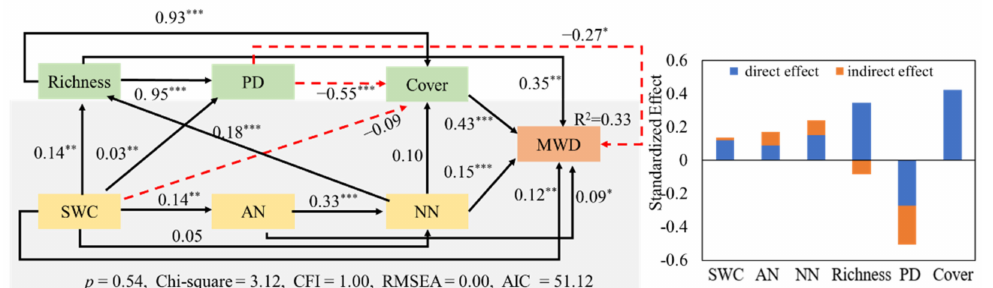
Figure 6. Effects of plant characteristics and soil factors on soil aggregate stability in the desert margin. Note: SWC, AN, NN, Richness, PD, and cover represent soil water content, soil ammonium nitrogen, soil nitrate nitrogen, species richness, phylogenetic richness, and plant coverage, respectively. Black solid lines indicate a positive effect and red dashed lines indicate a negative effect. Values on lines denote the standardized effect size and significance (* p < 0.05; ** p < 0.01; *** p <